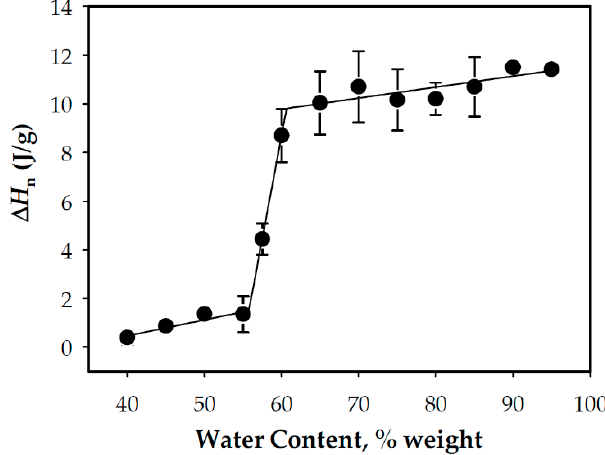
Figure 3. The specific endothermic enthalpy, ∆ H n , based on the G endotherm as a function of the water content in a wet basis. Table 2. Enthalpy of the gelatinization ( ∆ H e ) of waxy starches.